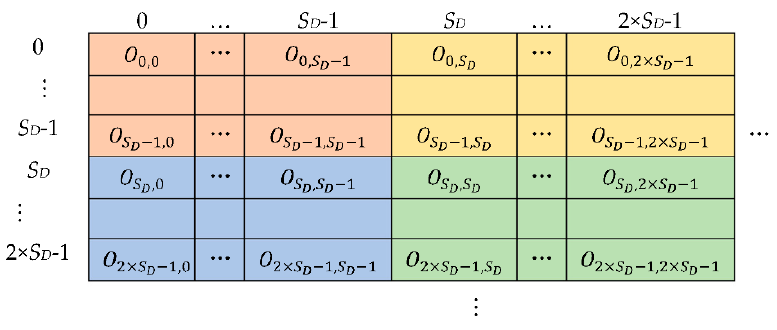
Figure 4. The arrangement of the computed results within the generic ofmap .